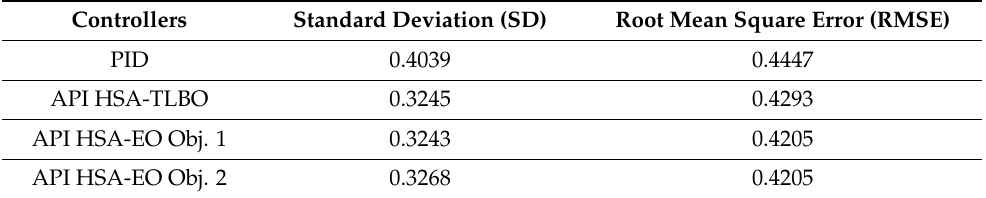
Table 3. Statistical analysis of the active power—normal first case.